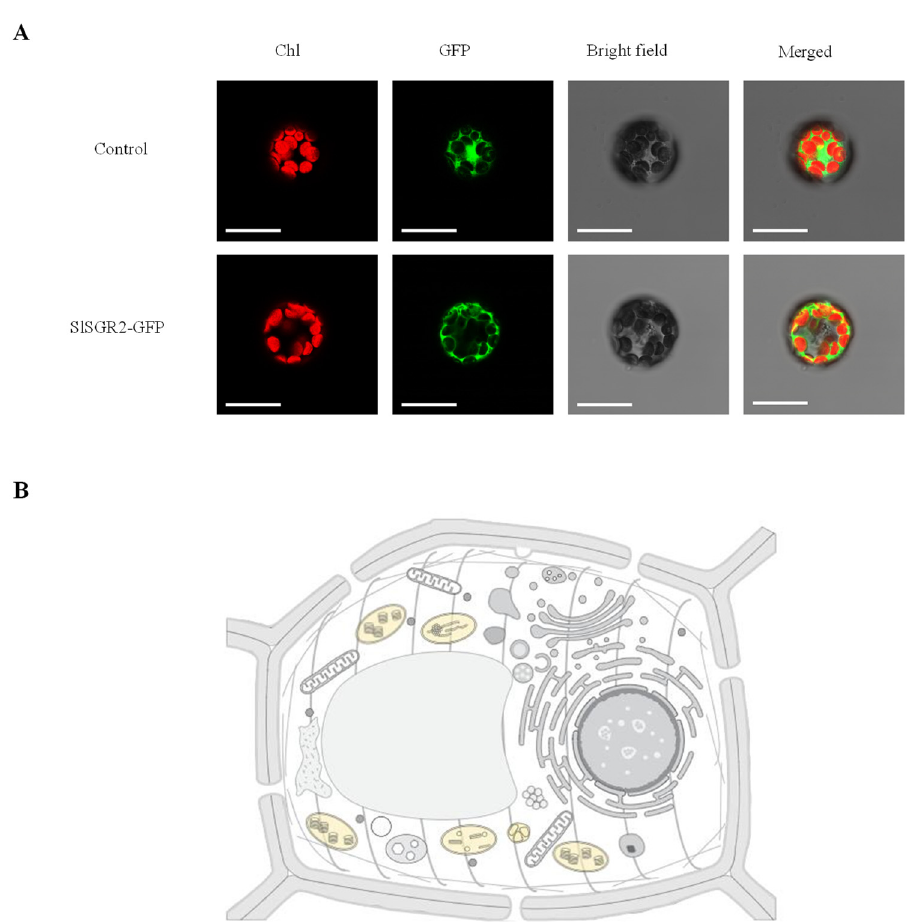
Figure 5. Subcellular localization of analysis of SlSGR2. ( A ) Transient expression of SlSGR2-GFP fusion proteins in Arabidopsis mesophyll protoplasts. Scale bar = 10 µ m. ( B ) Prediction of the SlSGR2 protein’s subcellular localization. The yellow part is the predicted location.